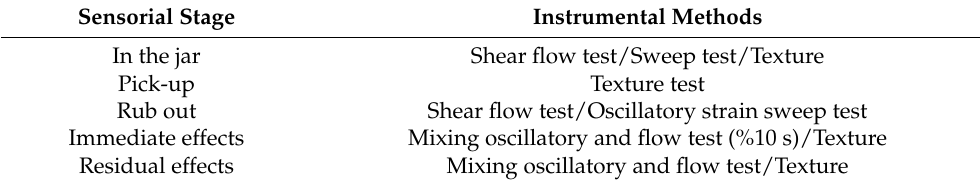
Table 2. Instrumental methods chosen according to sensorial